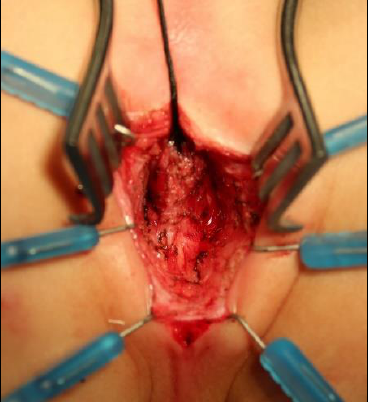
Figure 2. Rectum being dissected off spongi- osum body during a